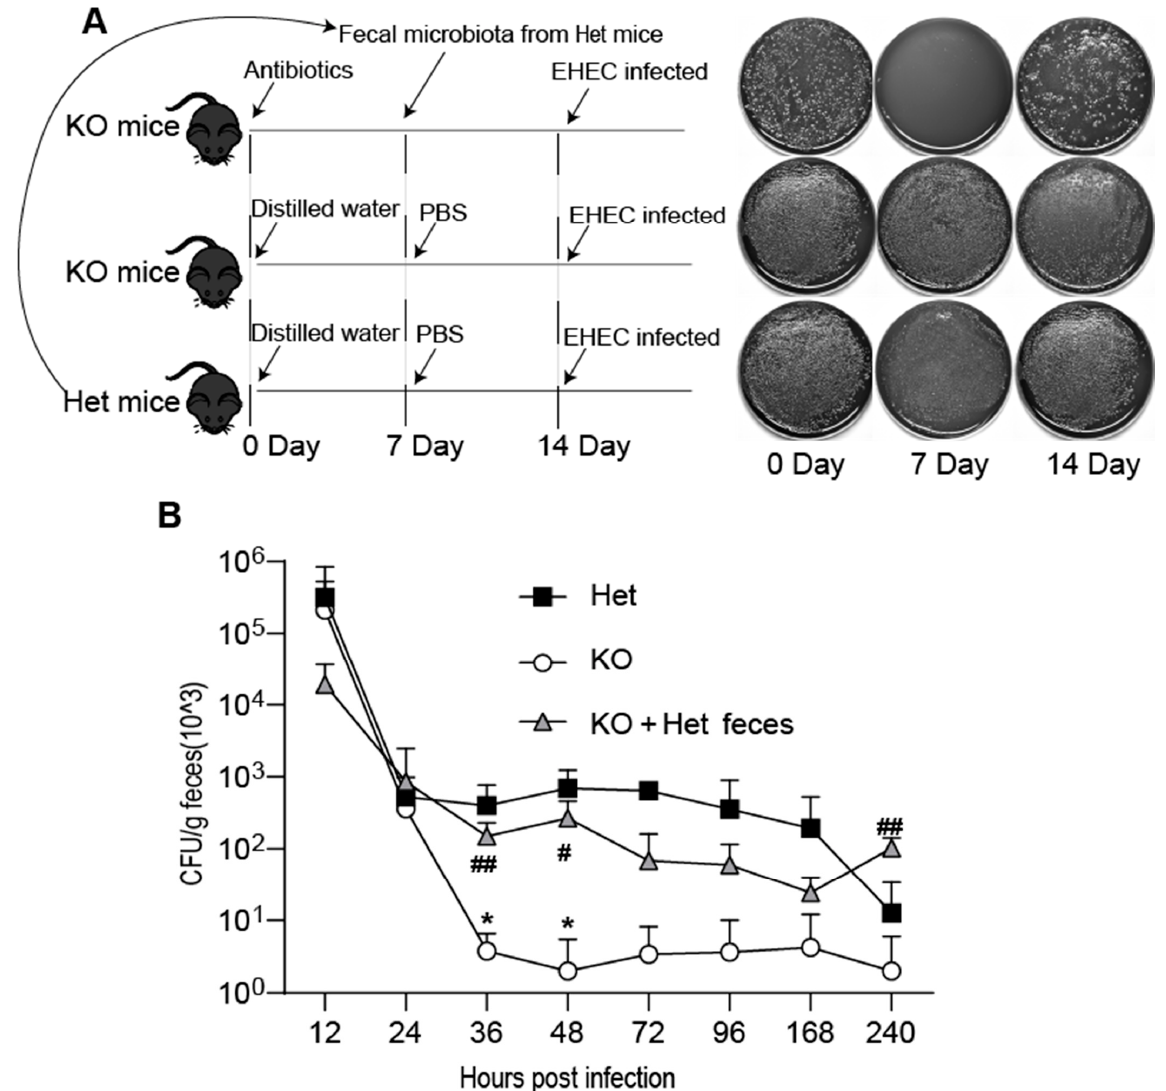
Figure 5. Verification of EHEC colonization ability after FMT. ( A ) Establishment of FMT. KO mice were used as recipients and Het mice were used as donors. Three groups of mice ( n = 6) were processed following the schematic diagram ( left ), and feces were collected on 0 days, 7 days and 14 days, and cultured on Columbia plates ( right ). ( B ) EHEC infected these three groups at the same dose. The feces at different points were collected, made into suspensions, and applied to Sorbitol-MacConkey agar plates after serial dilution. t -test, * represents group KO compared to group Het, * p < 0.05; # epresents group “KO+Het feces” compared to group KO, # p < 0.05, ## p < 0.01, error bars represent SEM. These experiments were repeated twice. KO, Knockout; Het, Heterozygote; EHEC, Enterohemorrhagic Escherichia coli ; PBS, phosphate-buffered saline.